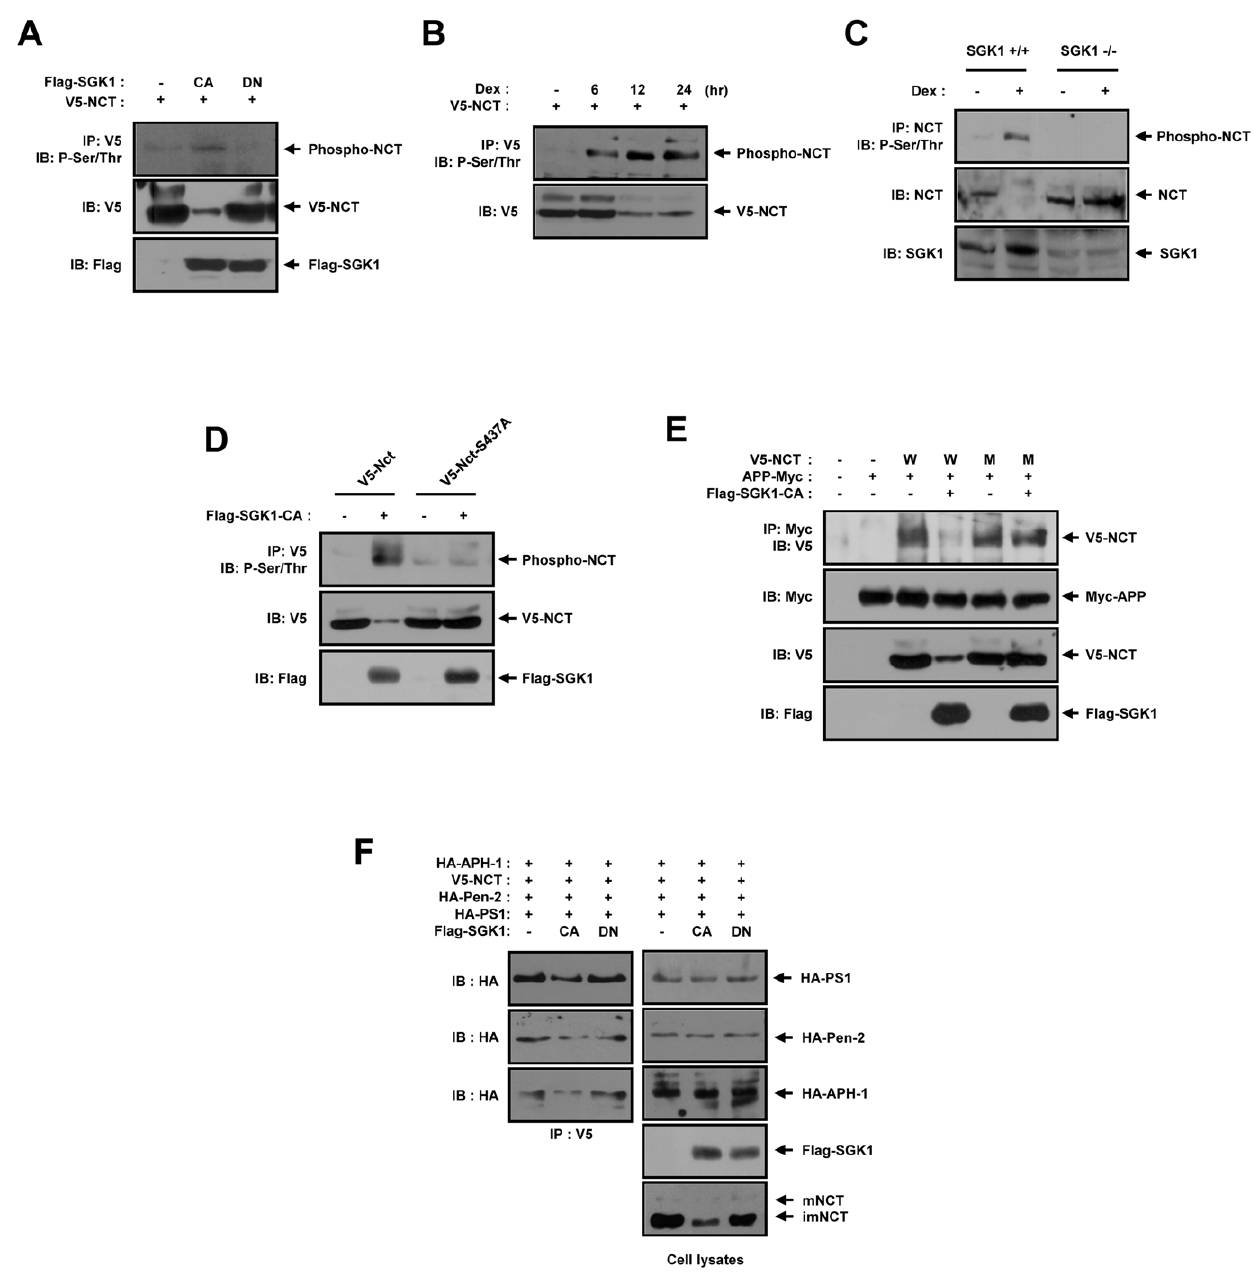
Figure 6. SGK1 phosphorylates NCT on Ser437, which facilitates degradation of NCT. (A) HEK293 cells were transfected with expression vectors encoding for 2 m g of V5-NCT, 4 m g of Flag-SGK1-CA, or Flag-SGK1-DN. After 48 hours of transfection, the cell lysates were subjected to immunoprecipitation with anti-V5 antibody. The immunoprecipitates were immunoblotted with anti-phospho Ser/Thr antibody. (B) HEK293 cells were transfected with expression vectors encoding for 2 m g of V5- NCT, then treated with 1 m M dexamethasone for 24 hours. After 48 hours of transfection the cell lysates were subjected to immunoprecipitation with anti-V5 antibody. The immunoprecipitates were immunoblotted with anti- phospho Ser/Thr antibody. (C) MEF cells from SGK1 + / + and SGK1 2 / 2 mice were treated with 1 m M dexamethasone for 24 hours. The cell lysates were subjected to immunoprecipitation with an anti-NCT antibody, and the immunoprecipitates were immunoblotted with anti-phospho Ser/Thr antibody. (D) HEK293 cells were transfected with expression vectors encoding for 2 m g of V5-NCT (WT, S437A), 6 m g of Flag-SGK1-CA. After 48 hours of transfection, the cell lysates were subjected to immunoprecipitation with anti-V5 antibody. The immunoprecipitates were immunoblotted with anti-phospho Ser/Thr antibody. (E) HEK293 cells were transfected for 48 hours with expression vectors encoding for the indicated combinations of 2 m g of V5-NCT, 2 m g of V5-NCT (S437A), 2 m g of APP-Myc, and 4 m g of Flag-SGK1-CA. Cell lysates were subjected to immunoprecipitation with an anti-Myc antibody (9E10), and the immunoprecipitates were immunoblotted with an anti-V5 antibody. (F) HEK293 cells were transfected for 48 hours with expression vectors encoding for the indicated combinations of 2 m g of V5-NCT, 2 m g of Flag-SGK1 CA, 2 m g of Flag-SGK1 DN, 2 m g of HA-PS1, 2 m g of HA-Pen2, and 2 m g of HA-APH-1. Cell lysates were subjected to immunoprecipitation with an anti-V5 antibody, and the immunoprecipitates were immunoblotted with an anti-HA antibody. (A–F) The cell lysates were also subjected to immunoblotting analysis with the indicated antibodies. These results represent one of three independent experiments. IB, Immunoblot. IP, Immunoprecipitation.